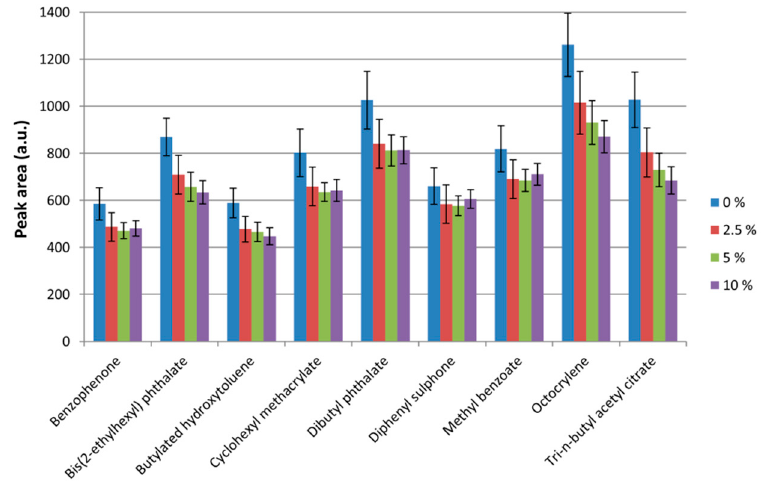
Figure 4. Study of the ionic strength. Experimental conditions: extraction solvent, n-hexane; extrac- tion solvent volume, 5 mL; extraction time, 60 s. Bars in the graph represent the mean value of three replicates ± standard deviation.